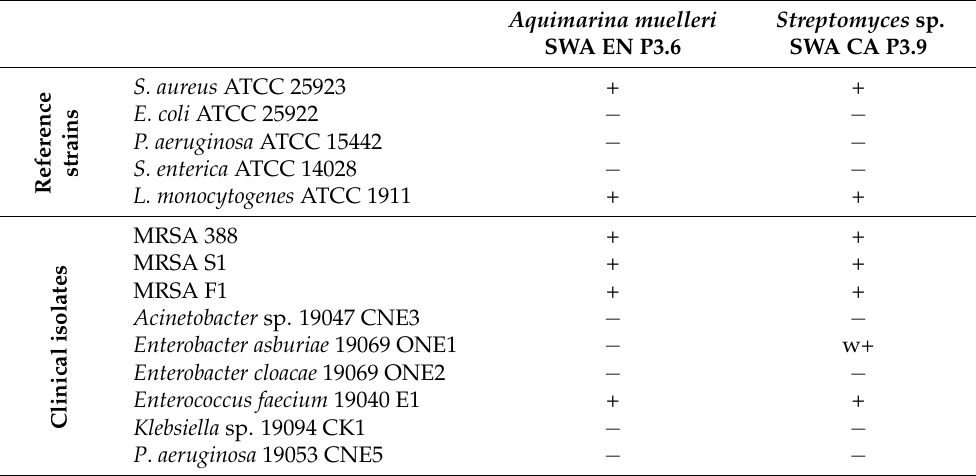
Table 2. Antimicrobial activity of marine bacterial strains against human pathogens 1